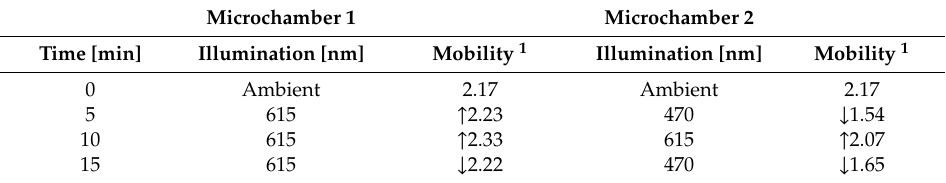
using the OLED matrix. Microchamber 1—by red color solely (favorable, reference wavelength of 615 nm), while microchamber 2—alternately by blue/red illumination (470/615 nm) for 5 min at each color. As a result (Table 2), in the case of microchamber 1, nearly equal mobility of euglenas was noticed, referring to typical behaviorism of these micro-objects. On the contrary, a different response of euglena was notified during the blue/red light switch on/off in microchamber 2. By applying the blue irradiation, a notable decrease in mobility occurred, revealing additional undesired, rotational movements of E. gracilis (Figure 6). Table 2. Comparison of E. gracilis mobility depending on the type of OLED irradiation in LOC microchambers.